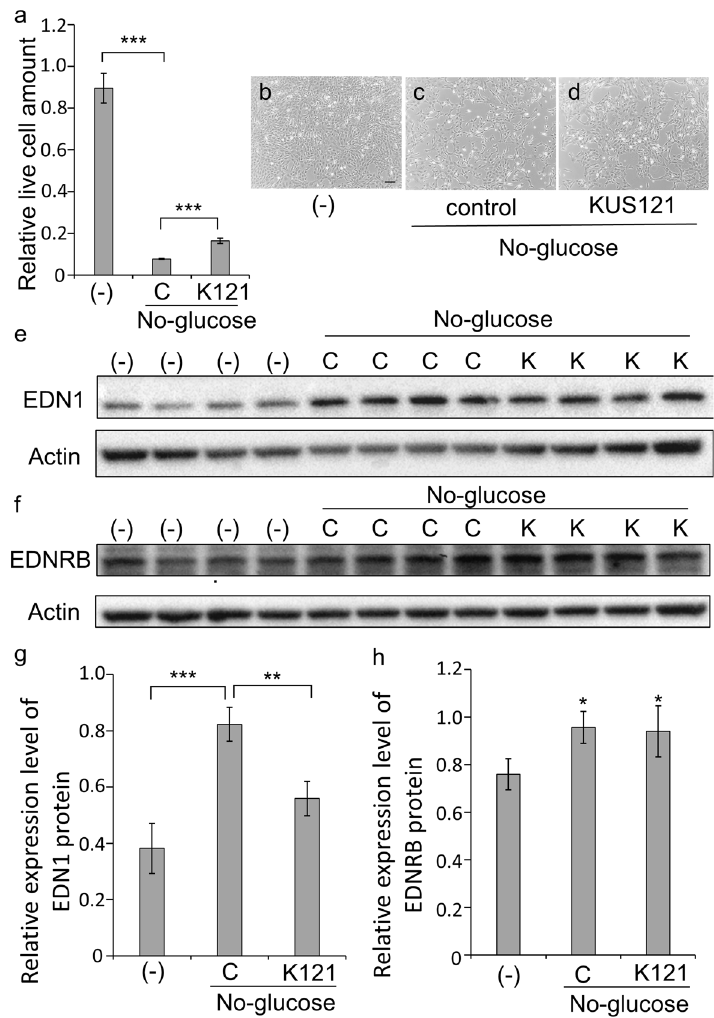
Figure 4. EDN1 and EDNRB protein expression and cell viability in 661W cultured cells under glucose- free conditions. ( a – d ) The relative amount of live cells was measured using WST-8 following 48 h treatment with DMEM/high glucose media or DMEM/glucose-free media with or without KUS121 (100 µM). ( a ) Quantitative analysis of live cells ( n = 3, for all treatments). 661W cells were cultured with high glucose [labeled ‘‘(-)’’] or treated in glucose-free media with (labeled ‘‘K121’’) or without (control, labeled ‘‘C’’) KUS121. ( b – d ) Representative images of 661W cells cultured under each condition. The black bar represents 50 µm. ( e – h ) Protein expression of EDN1 ( e , g ) and EDNRB ( f , h ) in 661W cells was analyzed by western blotting. 661W cells were cultured with high glucose media [labeled ‘‘(-)’’] or with glucose-free media with (labeled ‘‘K’’) or without (control, labeled ‘‘C’’) KUS121 for 24 h before the analysis. Actin was used as a loading control. Complete scans of western blots are shown in Supplementary Fig. S2b,c. Relative expression of EDN1 ( g ) and EDNRB ( h ) was shown as a ratio to actin ( n = 4, for both treatments). * p < 0.05, ** p < 0.01 and *** p < 0.001, compared with the control (in a and g ) or to the cells cultured in high glucose media (in h ), Tukey’s